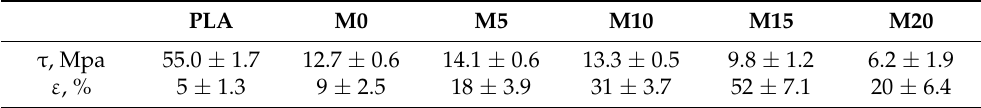
Table 3. Analytes’ mechanical test